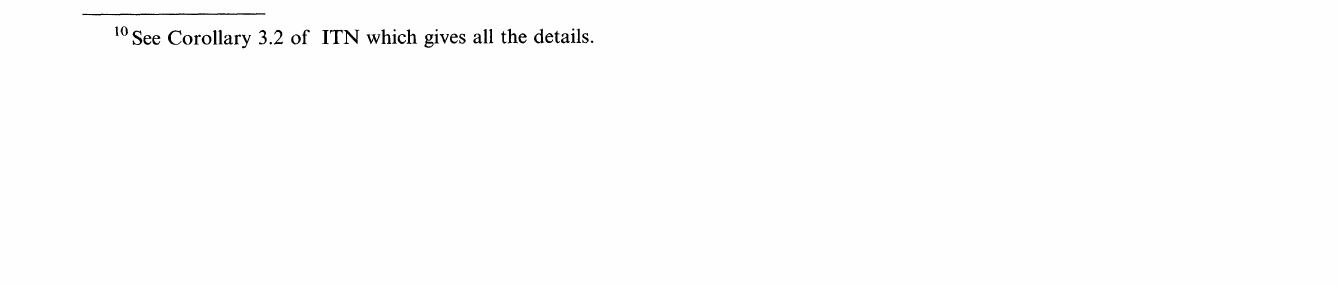
bifurcates to periodic chaos having the union of 2 m disjoint intervals as its attactor and then to ergodic chaos with one intervals. In the interval (0"3,0"4), there exists a stable period-3 cycle to which almost all trajectories converge. (5) implies that in the interval (0"4, 0"5), fU, has an absolutely continuous invariant measure. Its support is a union of three disjoint intervals for 0" close to 0"5 (i.e., 3-periodic chaos) while it is a union of six disjoint intervals for 0" close to 0"4. l Finally the ergodic chaos with one interval appears. If lIB is decreased from unity to zero along the lower st- raight line for